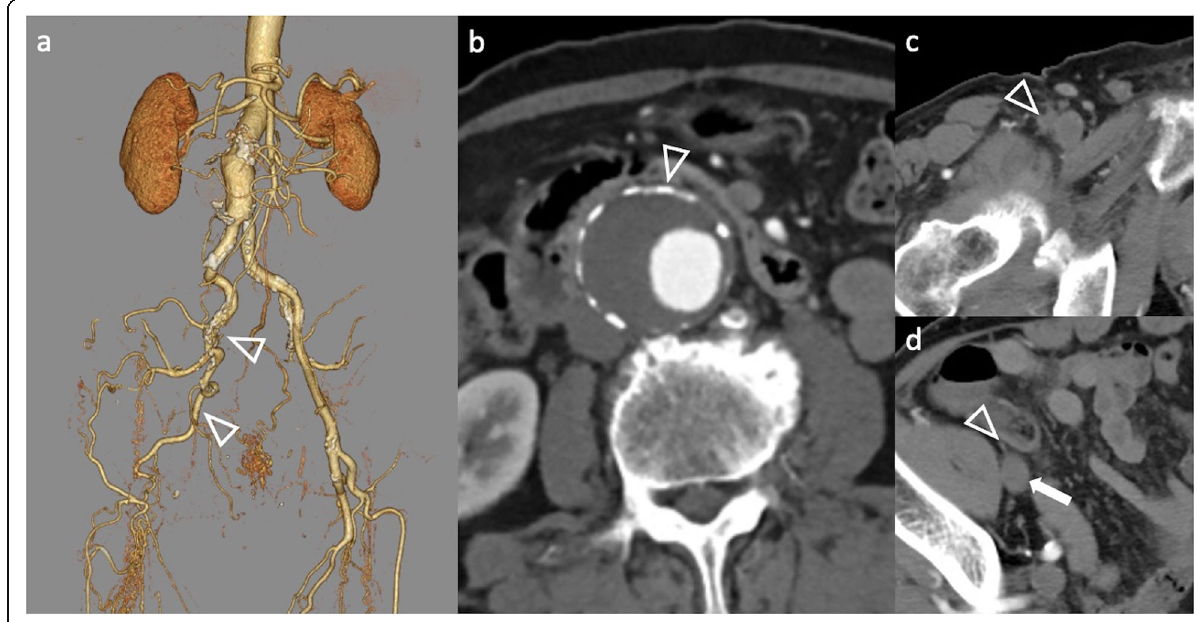
Fig. 1 CT before endovascular aneurysm repair. a VR image of CT angiography shows the occlusion of the right EIA to the SFA with collateral network from the right hypogastric artery (arrow heads), b Axial plane of CT shows AAA (arrow head), c Contrast enhanced CT shows occlusion of the right CFA (arrow head), d The occluded EIA (arrow head) was atrophied. Arrow shows EIV. CFA: common femoral artery, EIA: external iliac artery, EIV: external iliac vein, SFA: superficial femoral artery, VR: volume